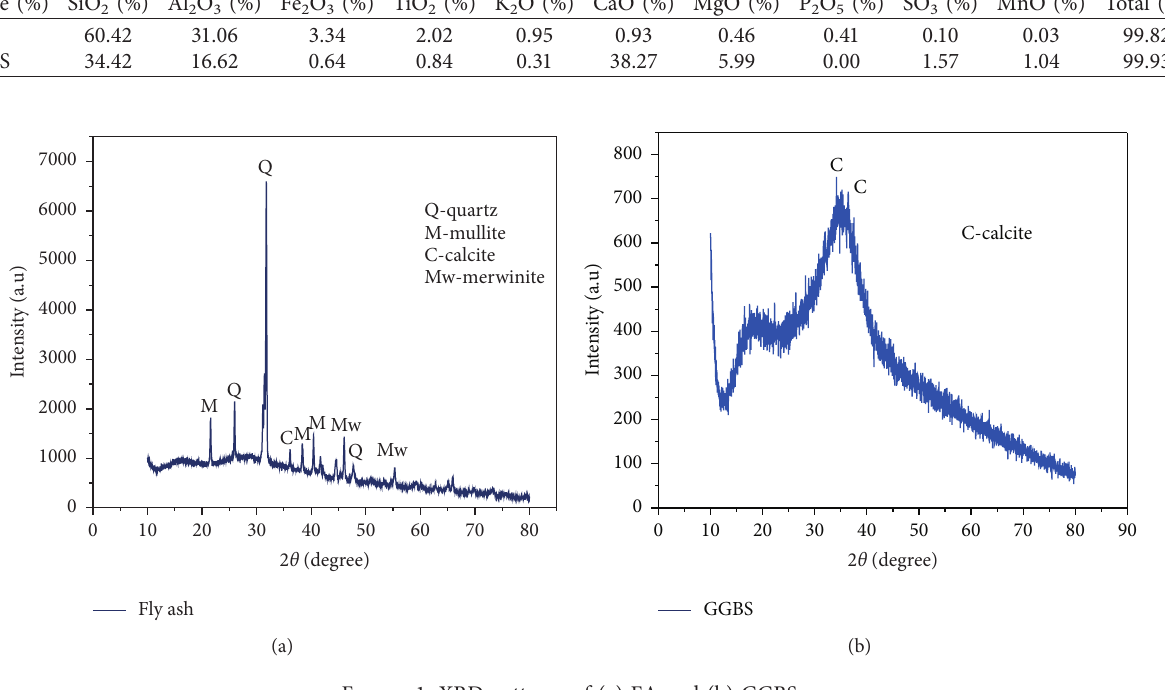
Figure 1: XRD patterns of (a) FA and (b) GGBS.